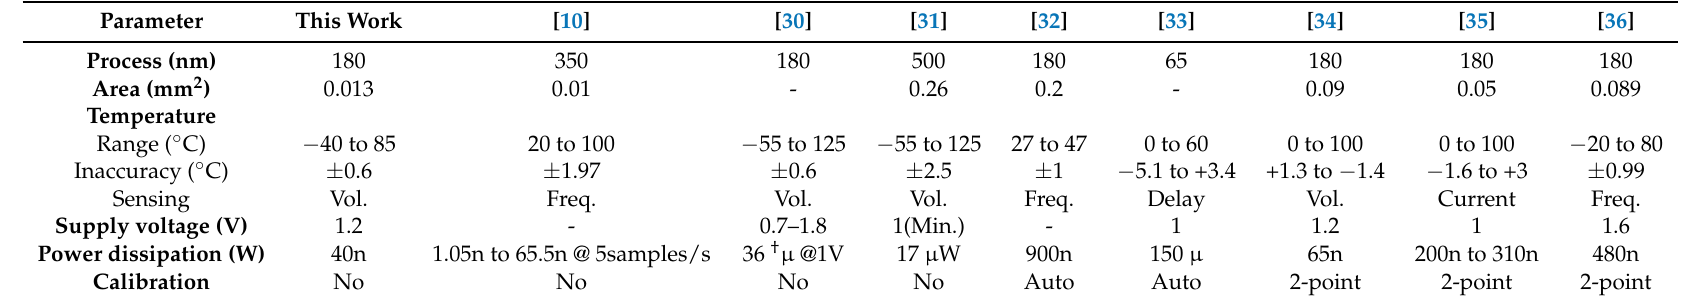
Table 1. Performance comparison with the-state-of-the-art temperature sensors available in